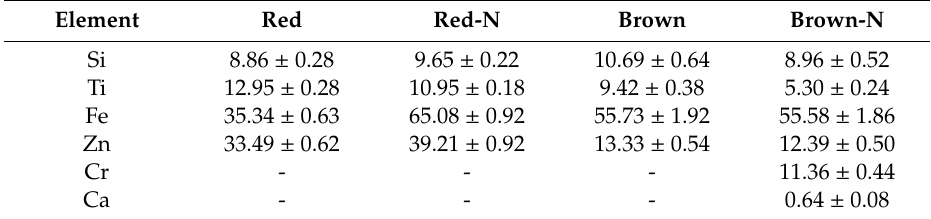
Table 2. Normalized mass in percentage (%) of elements in the samples. A high content of carbon and oxygen are obviously found (not reported), coming from the polymeric nature of the